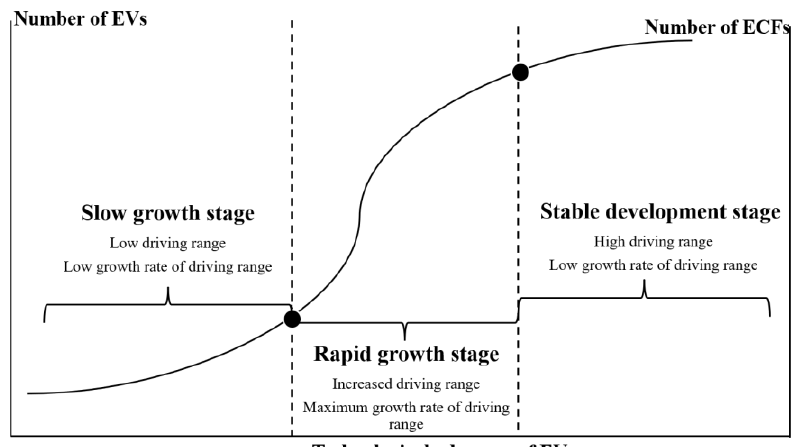
Figure 9. Three stages of EV technology development